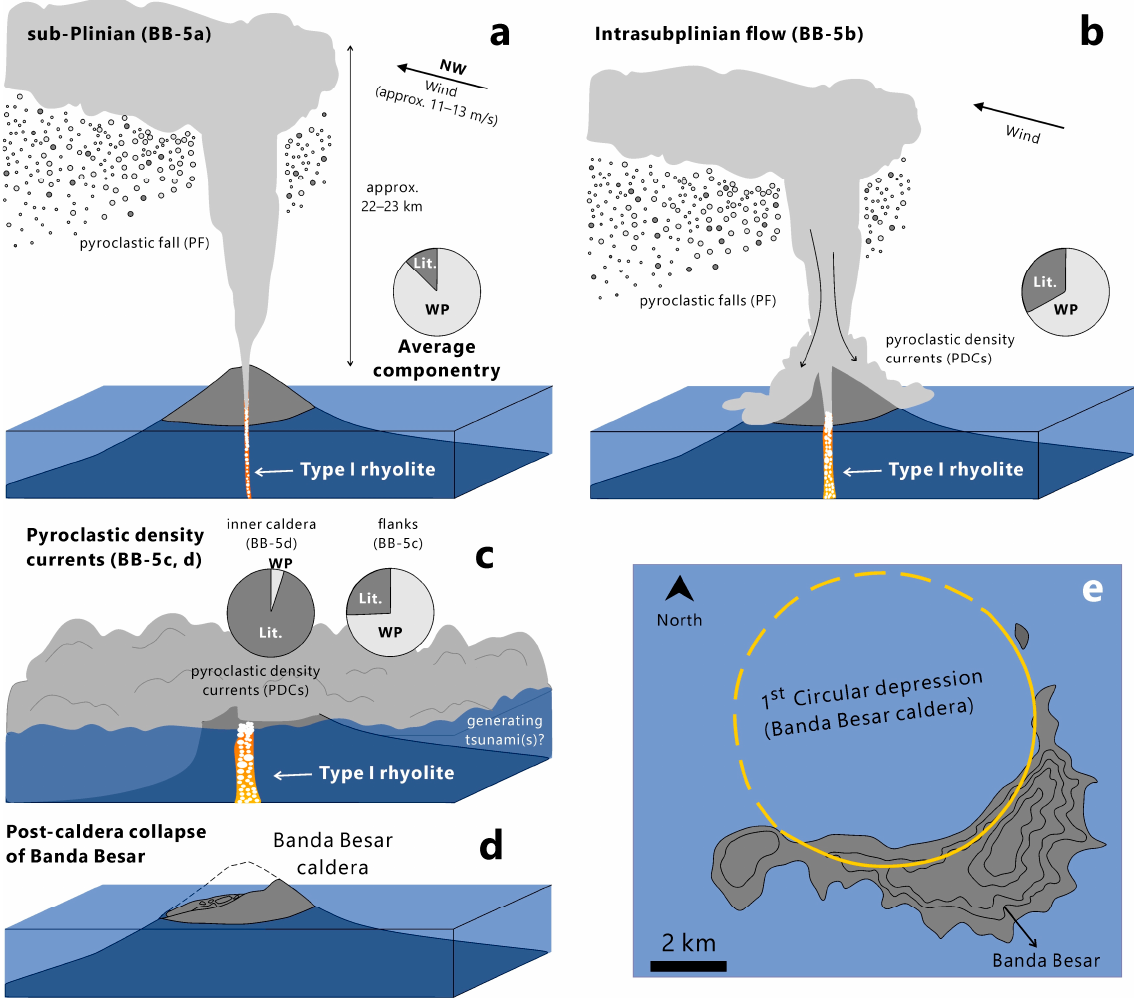
Figure 14. Formation of Banda Besar caldera. Pie charts are componentry results, with light grey and dark grey colors representing white pumice and lithics, respectively. Wind direction (as shown by the black arrow) is obtained from the direction of isopach (see also Figure 9). ( a ) The first caldera episode was initiated by a 22–23 km-high sub-Plinian column, producing white pumice falls (BB-5a). ( b ) The explosive behavior of the sub-Plinian caused intensive conduit wall erosion (indicated by higher lithic contents), leading to partial collapses of the buoyant plume and the formation an intra-Plinian flow deposit (BB-5b). ( c ) When conduit size surpasses the threshold value of the buoy- ant plume, the eruption completely shifts to pyroclastic density current (BB-5c and 5d). Finally, the dismissal of ±35.2 km 3 homogeneous rhyolite magma results in the first caldera collapse ( d ), forming the Banda Besar caldera ( e ).